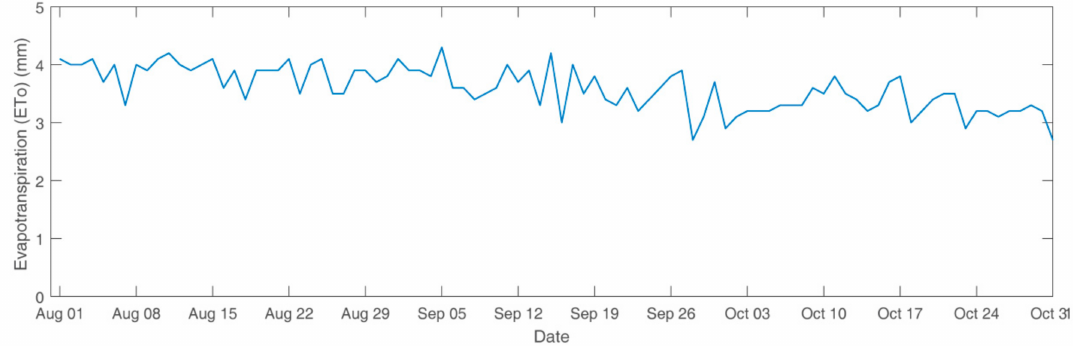
Figure 2. Daily potential evapotranspiration (ETo) during the growing season